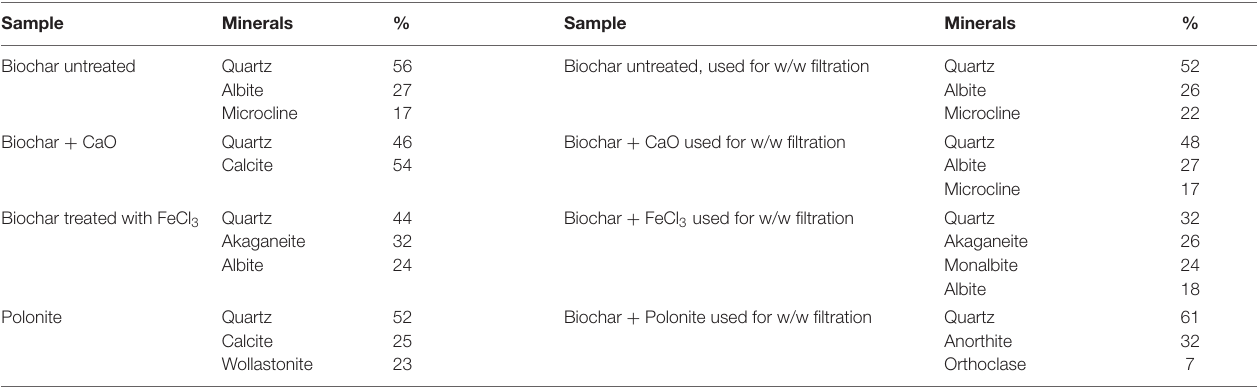
TABLE 3 | Mineral content of biochar surfaces characterized using X-ray diffraction analysis. Sample